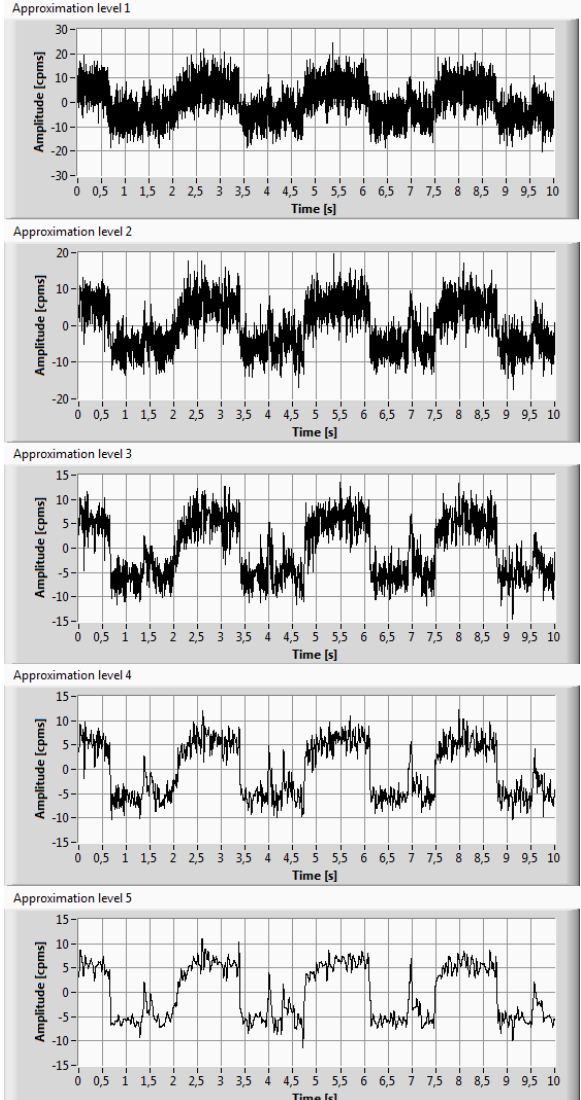
Fig. 7. Decomposition of the x ( n ) signal into low-frequency components (approximations) in the LIW5 experiment.